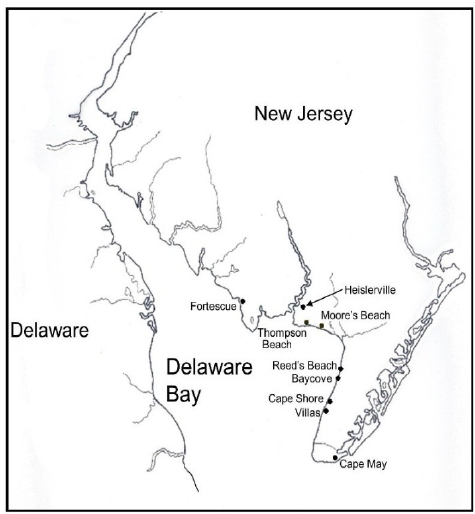
Figure 1. Map showing locations where feathers were collected from shorebirds migrating through Delaware Bay, New Jersey, USA, in the